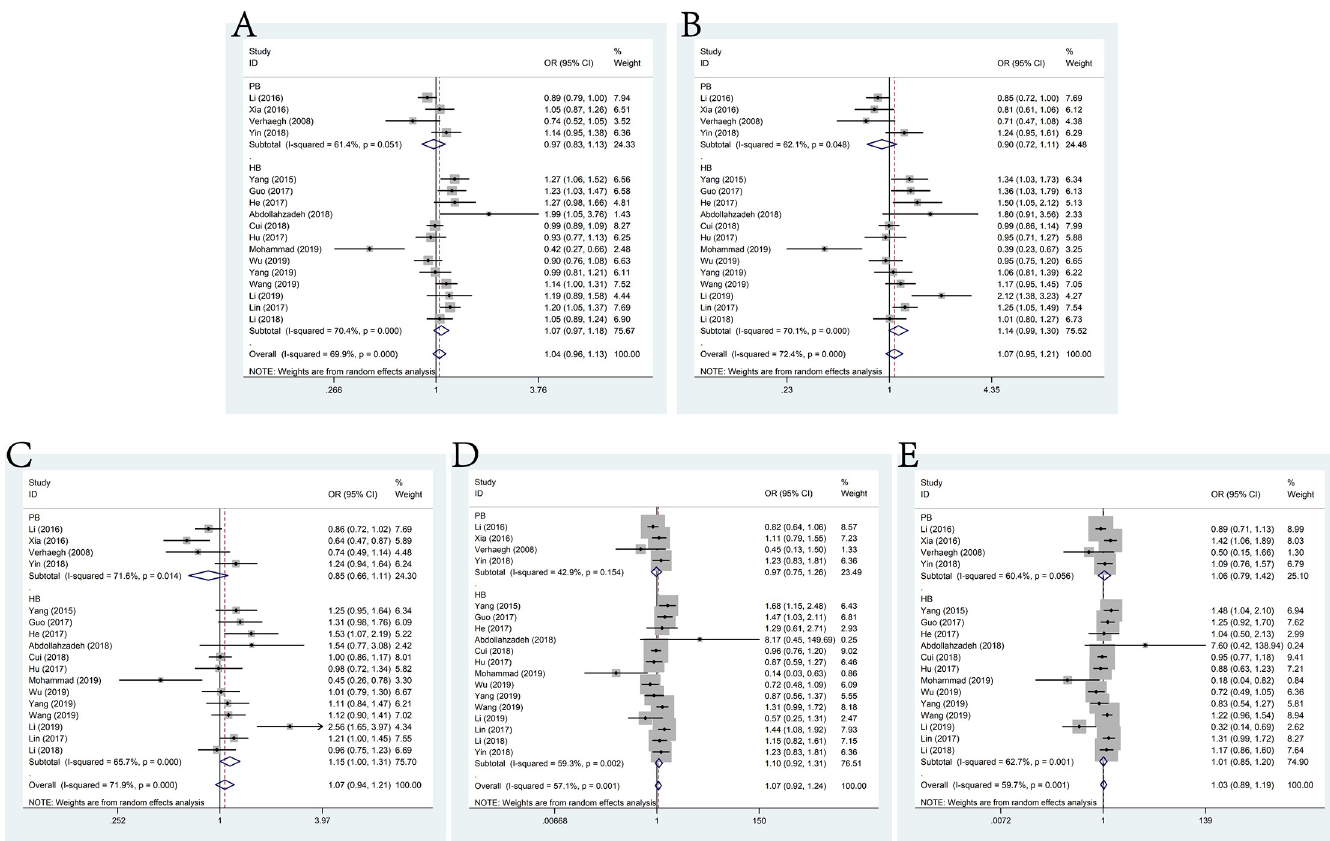
Fig 3. Forest plot of the association between H19 polymorphism rs217727 G > A and cancer susceptibility. A: allele model; B: dominant model; C: heterozygote model; D: homozygote model; E: recessive model.